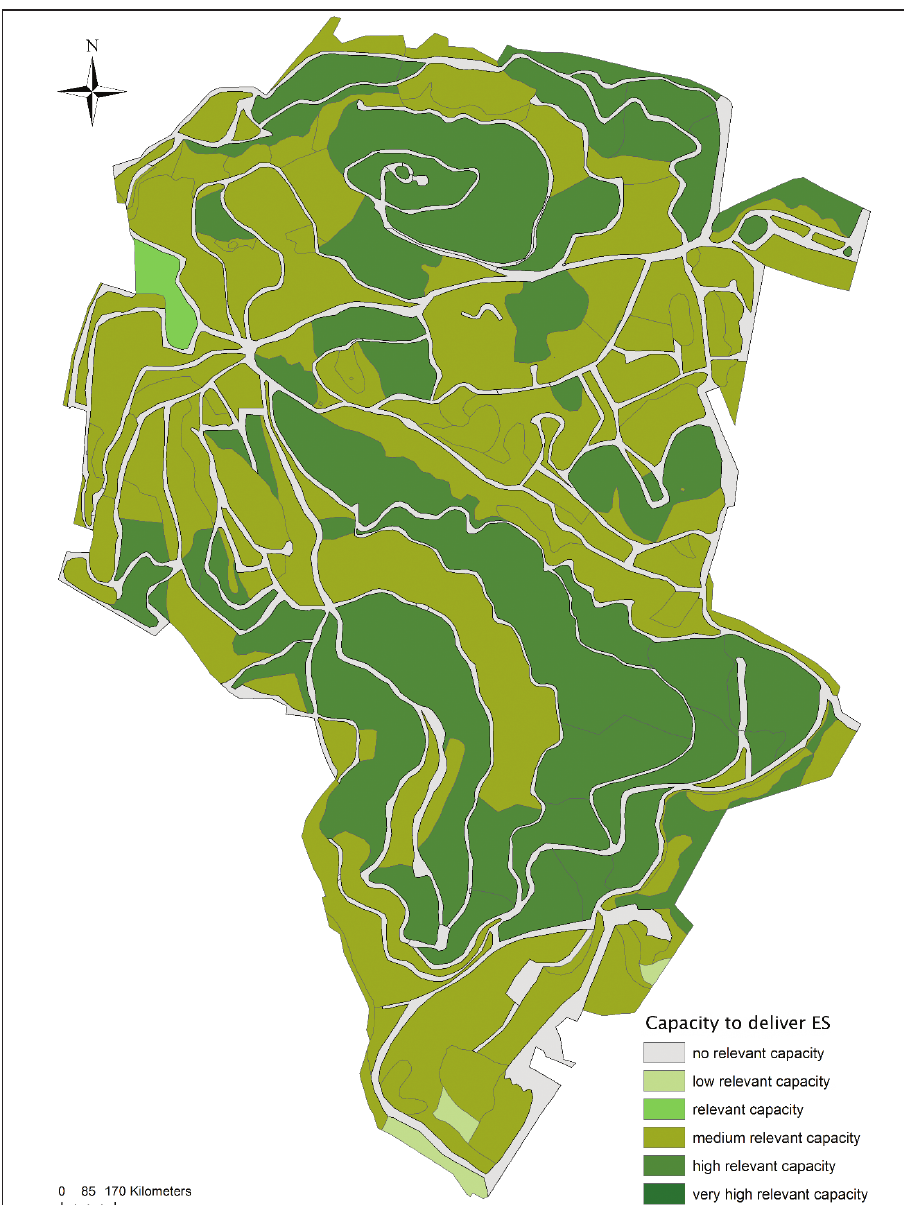
Figure 2. Capacity of habitat types in the study area to deliver ES (based on ES matrix approach de- scribed in the